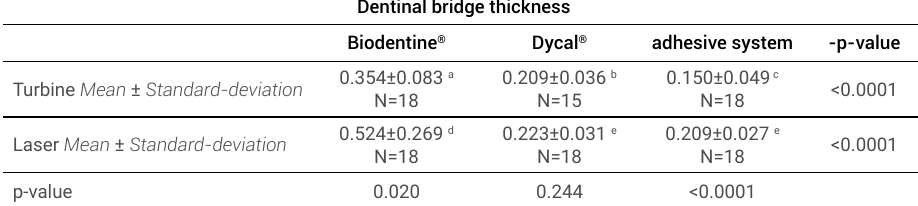
Table 1. Dentinal bridge thickness among different